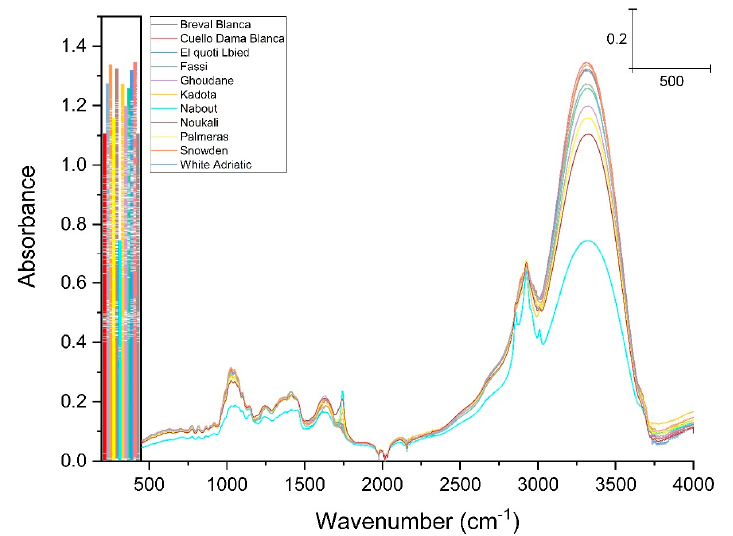
Figure 2. FTIR spectra of sampled figs within the wavenumber of 4500–450 cm − 1 .